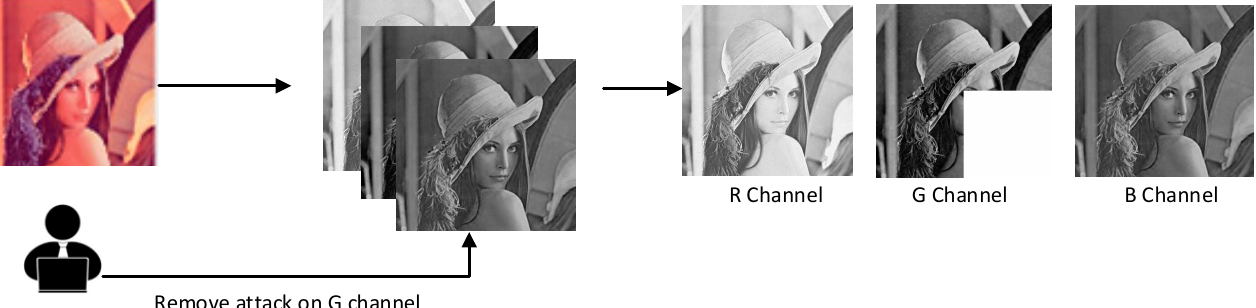
Figure 3. Schematic diagram of single-channel a tt ack.